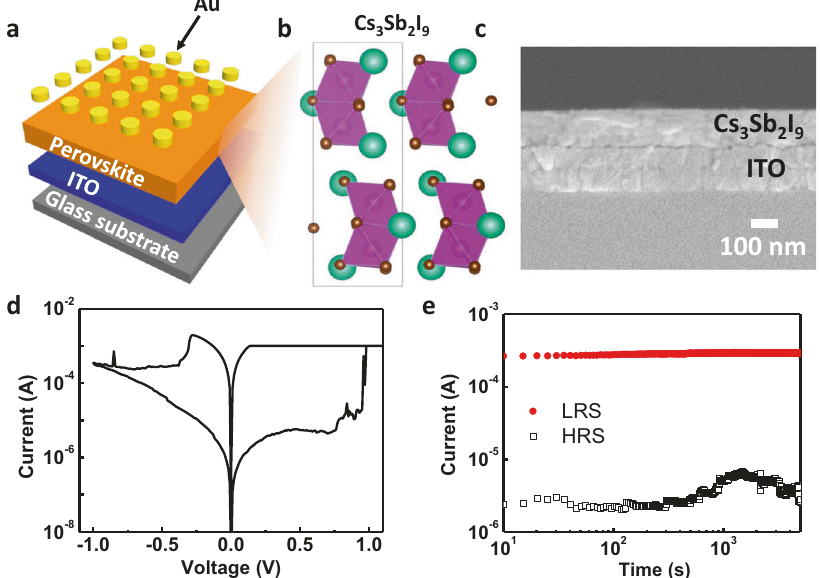
Fig. 3 Schematic illustration and electrical characterstics of HP RSM. a Schematic illustration of RSM device using dimer-Cs 3 Sb 2 I 9 deposited by a spin- coating process. b Schematic structure of dimer-Cs 3 Sb 2 I 9 (atom colors: Cs = blue-green; Sb = purple; I = brown). The rectangular box in schematic structure is the unit cell of crystal structure. c Cross-sectional scanning-electron microscopy (SEM) image of dimer-Cs 3 Sb 2 I 9 layer on ITO. d I – V characteristics of dimer-Cs 3 Sb 2 I 9 RSM. e Data retention properties of the dimer-Cs 3 Sb 2 I 9 RSM.